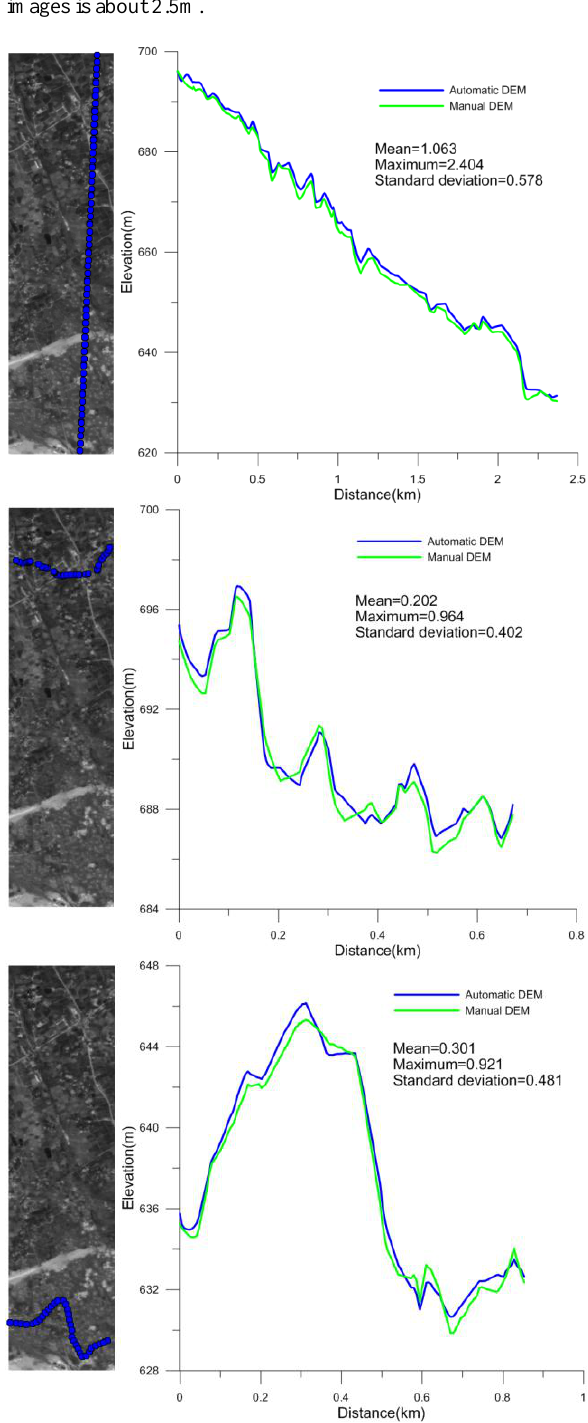
Figure 7. Elevation profile of automatically and manually generated DEM of three